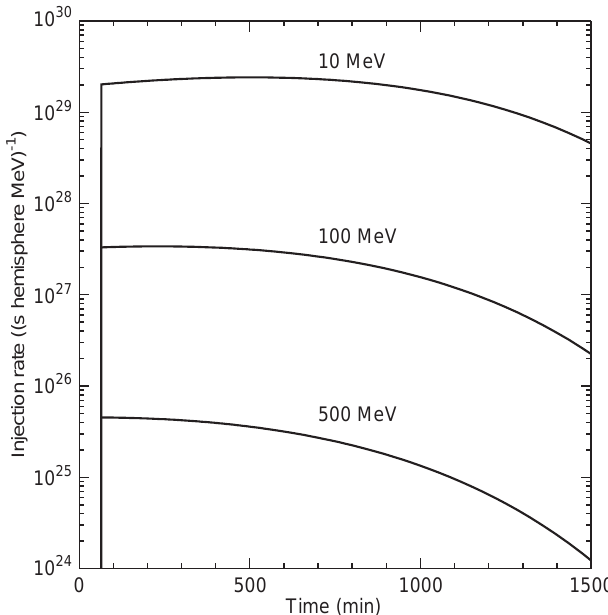
Fig. 5. The interplanetary shock injection profile for the 19 October SEP event at energies 10, 100 and 500 MeV in units of p/ (s (cid:225) hemisphere (cid:225) MeV). The time starts from the X-ray onset at the Sun